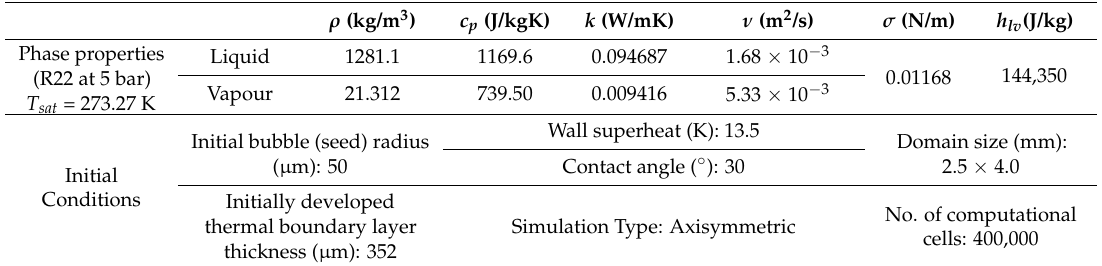
Table A5. Fluid properties and initial conditions (base case for R22, at 5 bar). ρ (kg/m 3 )